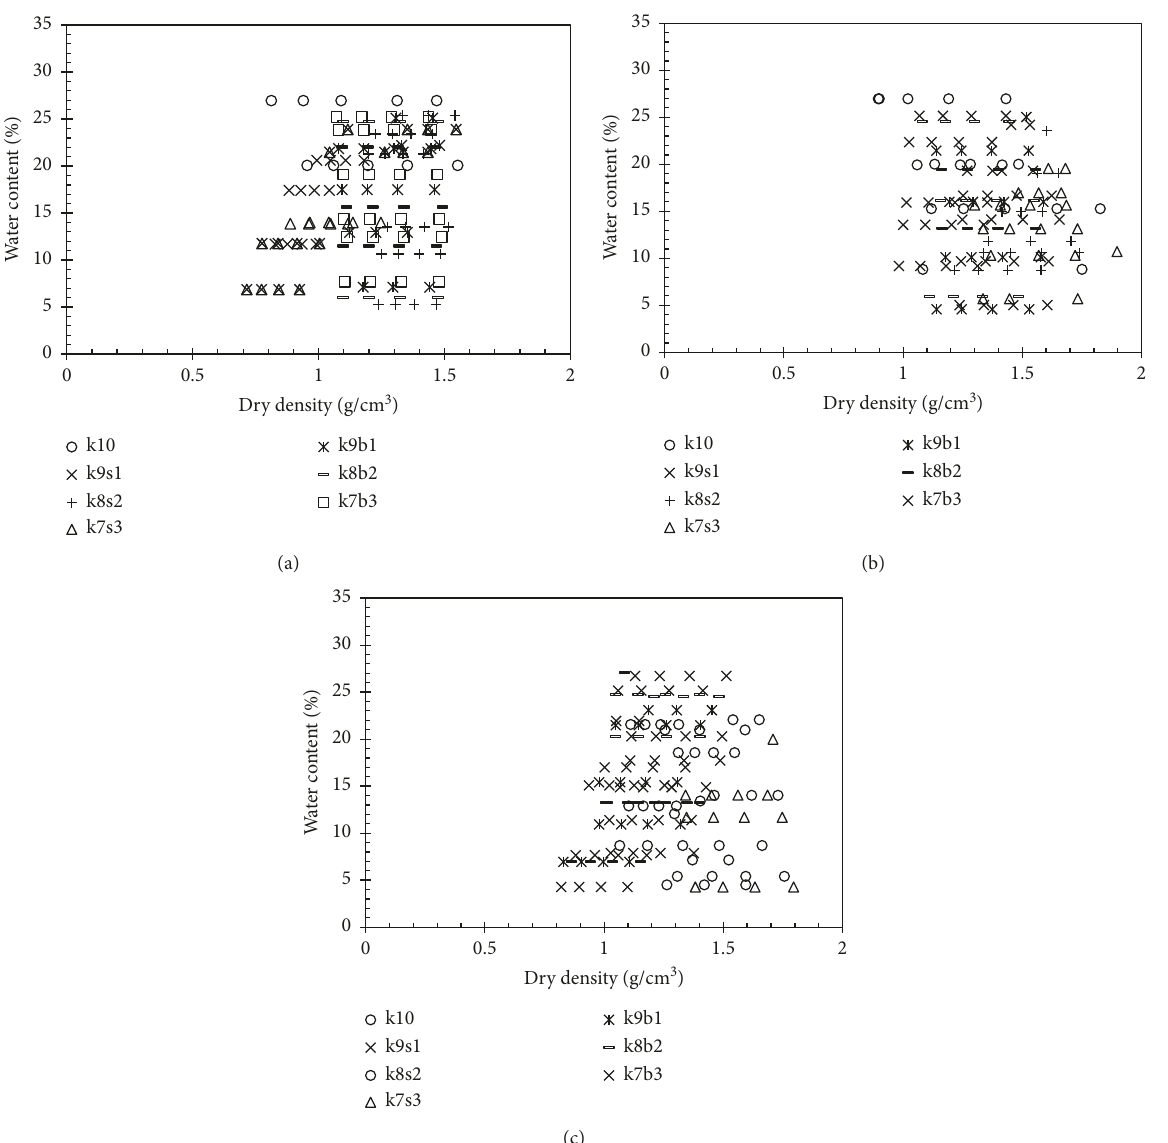
Figure 4: Water content (%) against dry density (g/cm 3 ) of kaolin (K), kaolin-sand (K-S), and kaolin-bentonite (K-B) constituted at different salt concentrations: (a) 0M, (b) 0.5M, and (c) 1